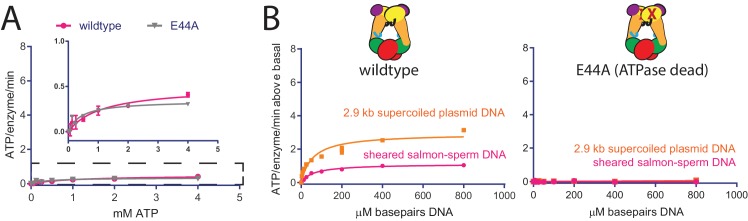
Determination of contaminating ATPase activity levels present in topo VI preparations using a hydrolysis-deficient mutant.(A) Rate of steady-state ATP hydrolysis measured as a function of ATP concentration for topo VI alone and an ATPase-deficient construct of topo VI (Top6BE44A). Rates were determined spectroscopically using an NADH-coupled assay (Materials and methods). Points and error bars correspond to the mean and standard deviation of three independent experiments. Measured rates for Top6BE44A were used to estimate the topo VI-specific ATPase rates presented in Figure 2A. (B) Stimulation of ATP hydrolysis above basal levels catalyzed by wildtype topo VI (left) or the Top6BE44A ATPase-deficient construct (right) as a function of the basepair concentration (µM) of sheared salmon-sperm, DNA (pink), or a 2.9 kb supercoiled plasmid (orange). ATP was held at 2 mM, and rates were determined spectroscopically using an NADH coupled assay. Points and error bars correspond to the mean and standard deviation of three independent experiments. Numerical data for (A–B) are reported in Figure 2—source data 1.